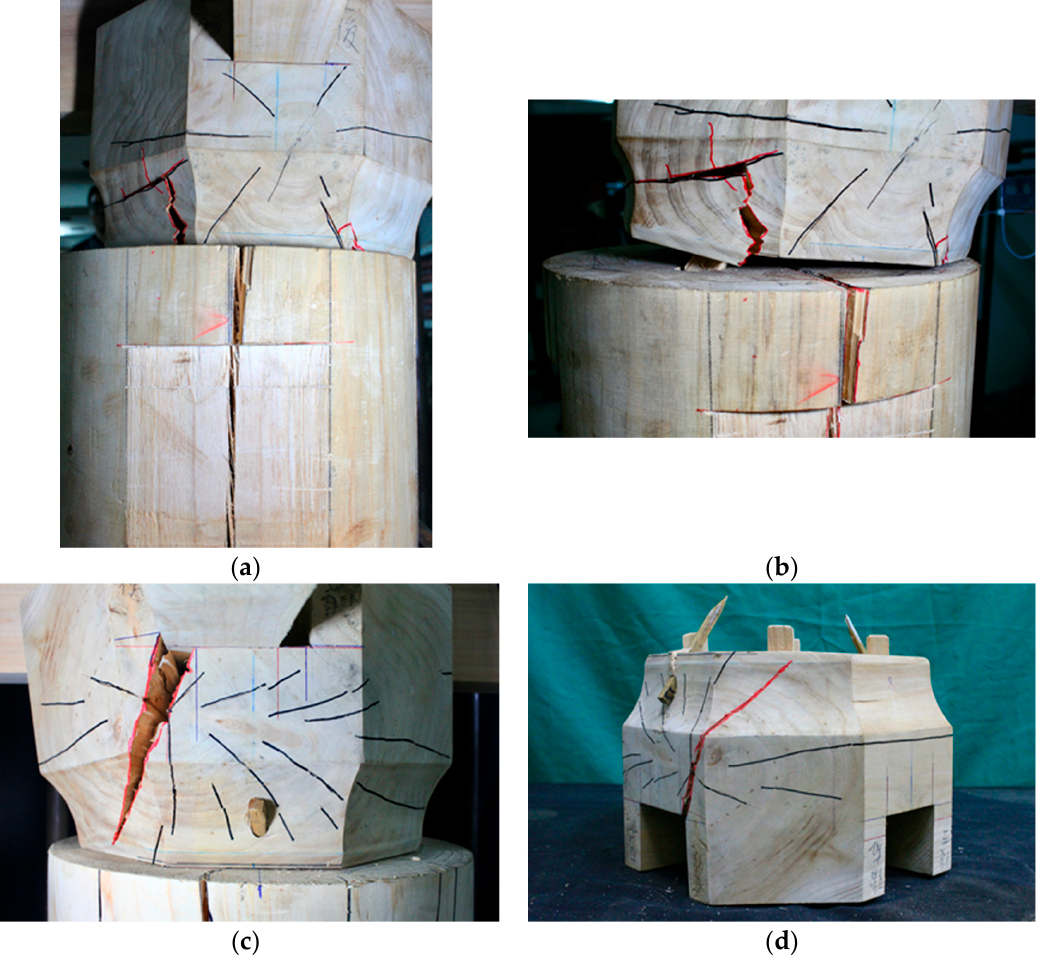
Figure 19. Failure modes of Zuo-Dou after shear test: ( a ) crack due to shear force, specimen No. 8; ( b ) failure of the wooden teeth, specimen No. 9; ( c ) bamboo nail restricting rocking, specimen No. 13; ( d ) Zuo-Dou and bamboo nail, specimen No.